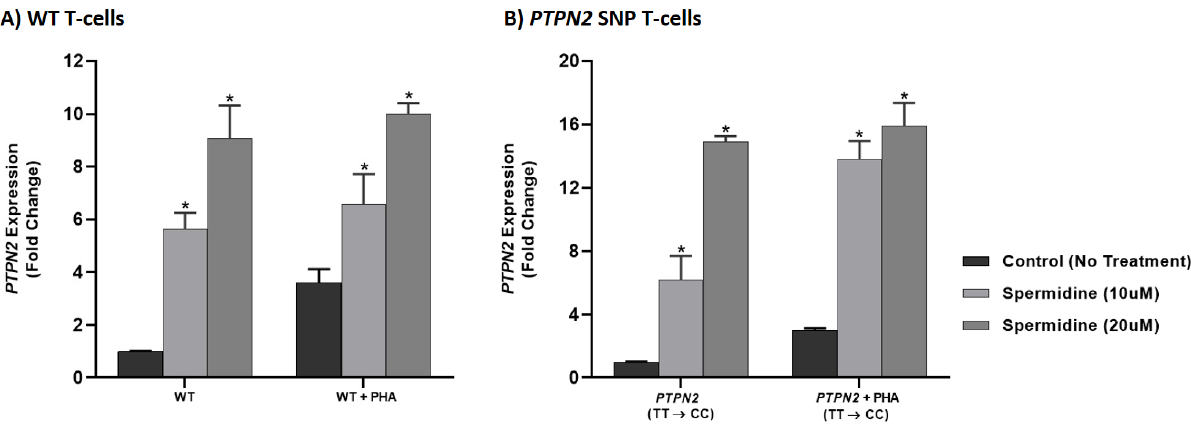
Figure 5. Effect of Spermidine on PTPN2 Expression in WT and PTPN2 SNP Jurkat T-cells stimulated with PHA ( n = 3). RT-PCR was used to measure expression of PTPN2 in ( A ) WT and ( B ) PTPN2 SNP T-cells stimulated with PHA (10 µ g/mL) and treated with spermidine (0, 10, 20 µM). Significance among experiments was assessed by one-way analysis of variance (ANOVA) followed by Tukey’s multiple comparison test and cross checked with Wilcoxon matched-pairs test for non- parametric tests. * p < 0.05 compared to unstimulated or untreated cells for each cell type.